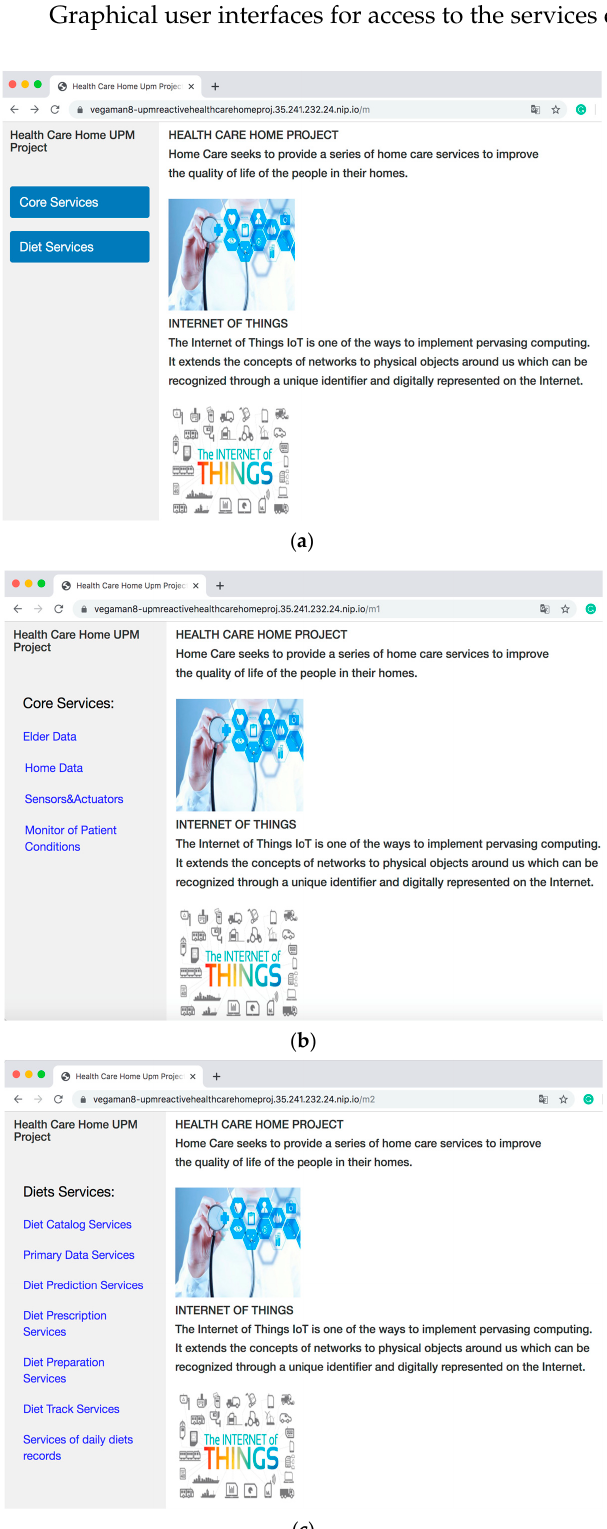
Figure A3. Detailed view of the deployment of the specific software in the cloud from the Docker Hub repository.